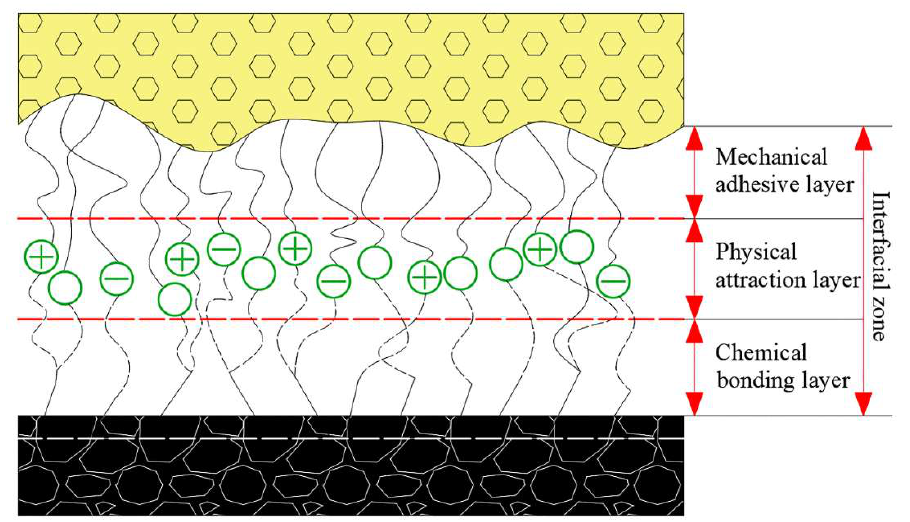
Figure 23. Interface model schematic diagram of polymeric foaming (PF) material [111].